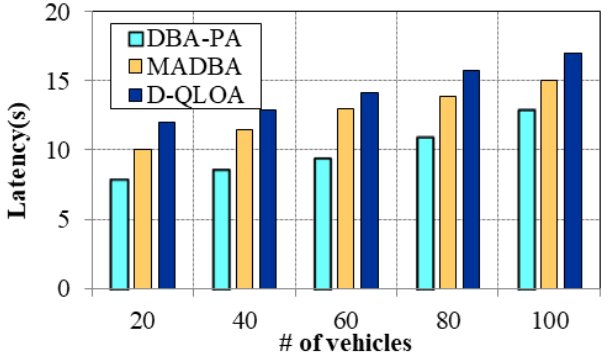
Figure 11. Number of Vehicles vs. Latency.